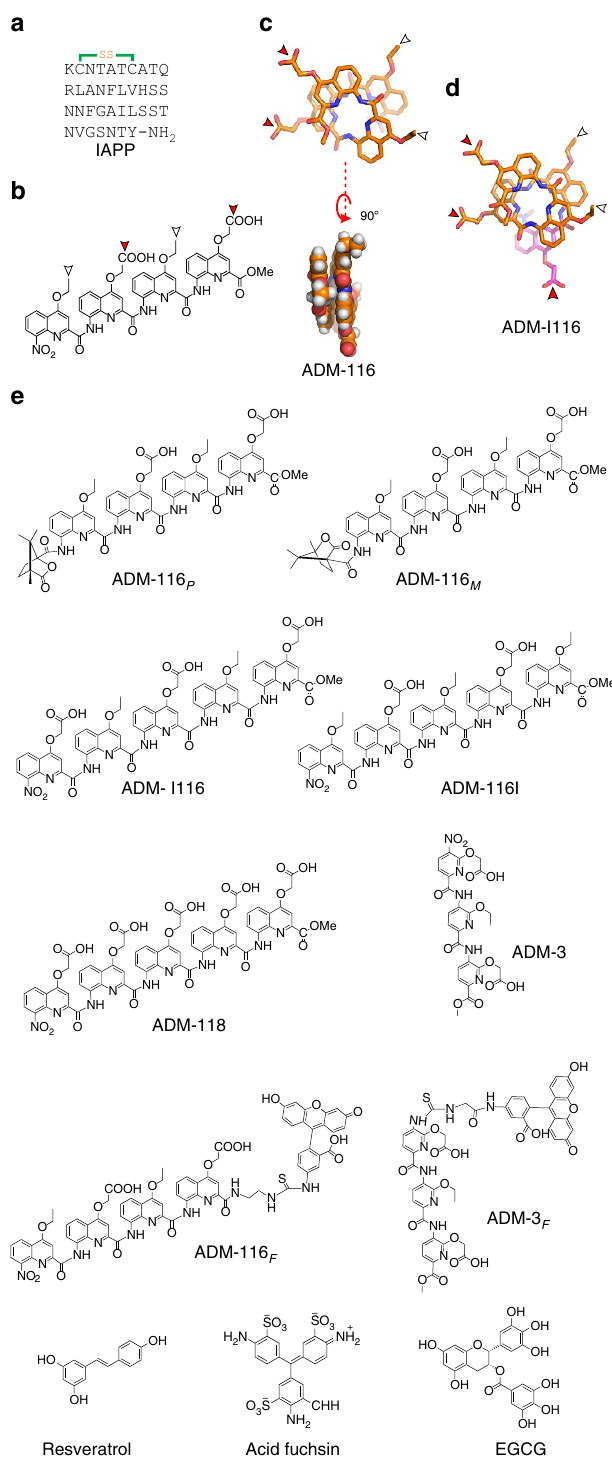
Figure 1 | Structures of compounds. ( a ) Primary sequence of human IAPP. Wild-type IAPP is C-terminally amidated and has an intramolecular disulfide bond between residues 2 and 7. ( b ) Chemical structure of ADM-116. ( c ) Three-dimensional stick (top) and sphere (bottom) model of ADM-116. ( d ) Pentaquinoline, ADM-|116, in which ADM-116 is extended one residue from the N terminus. Arrows in a , b and d indicate surface-exposed functional moieties. Structures in b and d adapted from a longer oligoquinoline 47 . ( e ) Chemical structures of other molecules used in this